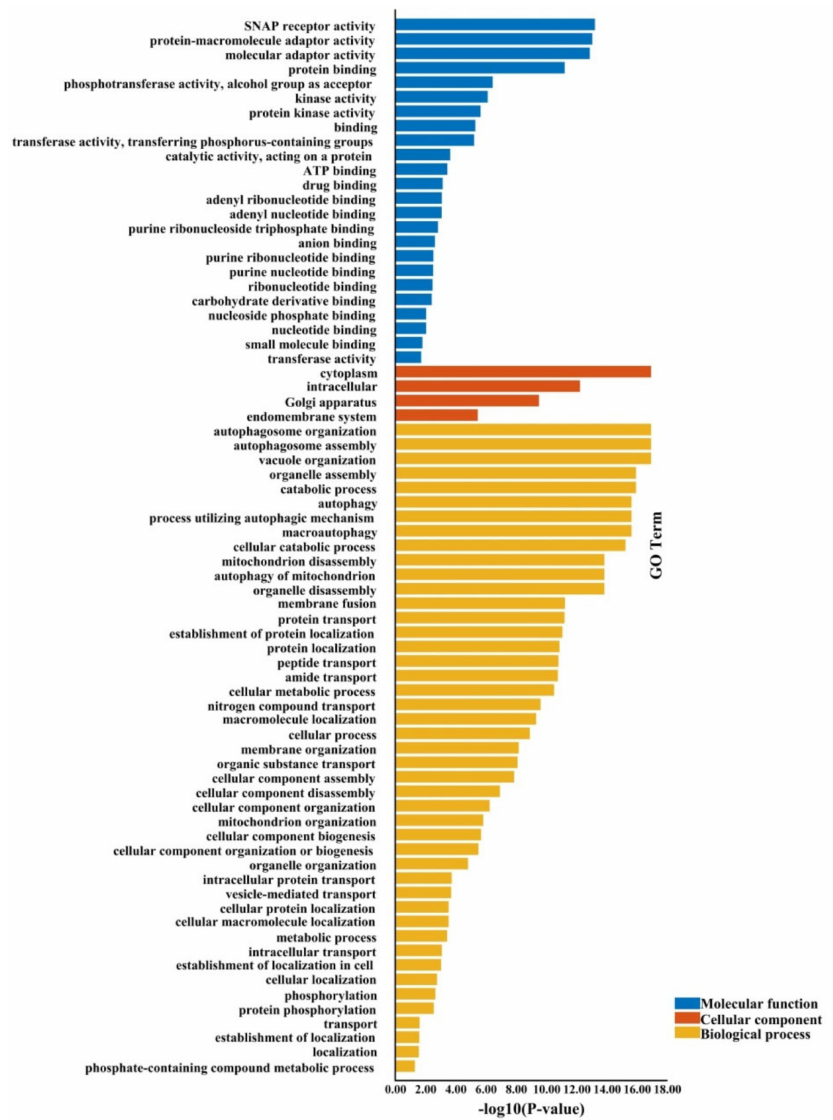
Figure 8. Gene ontology (GO) annotations of ATG genes in B. napus . GO analysis performed using